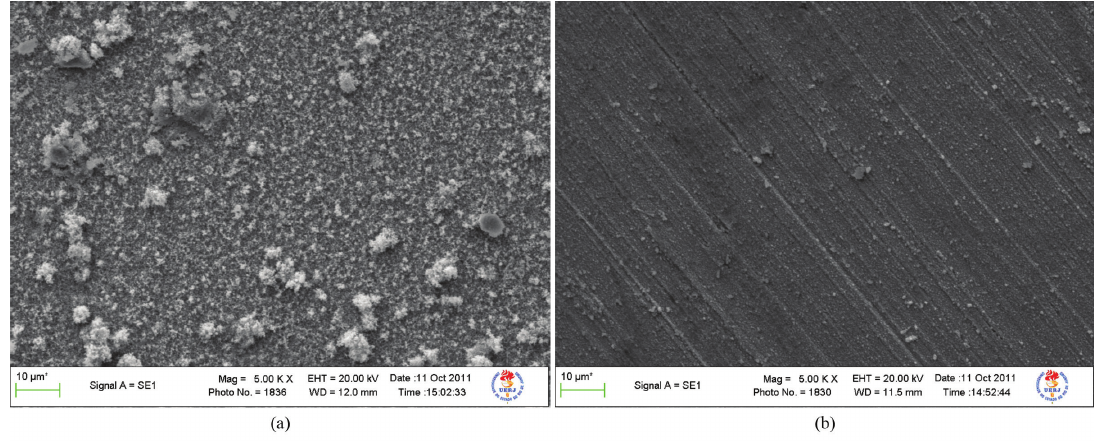
Figure 7. Surface morphology evaluation of the Zn-Co coatings produced from the selected experiments shown in Table 2. (a) Experiment 1; (b) Experiment